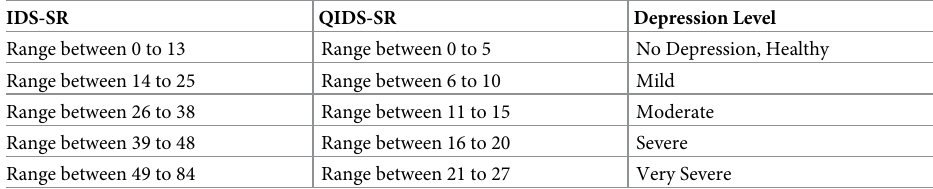
possible to follow up on their health condition. 18% (9 out of 50) of the participants had severe and mild symptoms. The patients with severe symptoms were advised to attend a medical con- sultation when possible so the condition did not escalate but the participants with mild symp- toms were not required to visit a health care professional, however they were asked to read